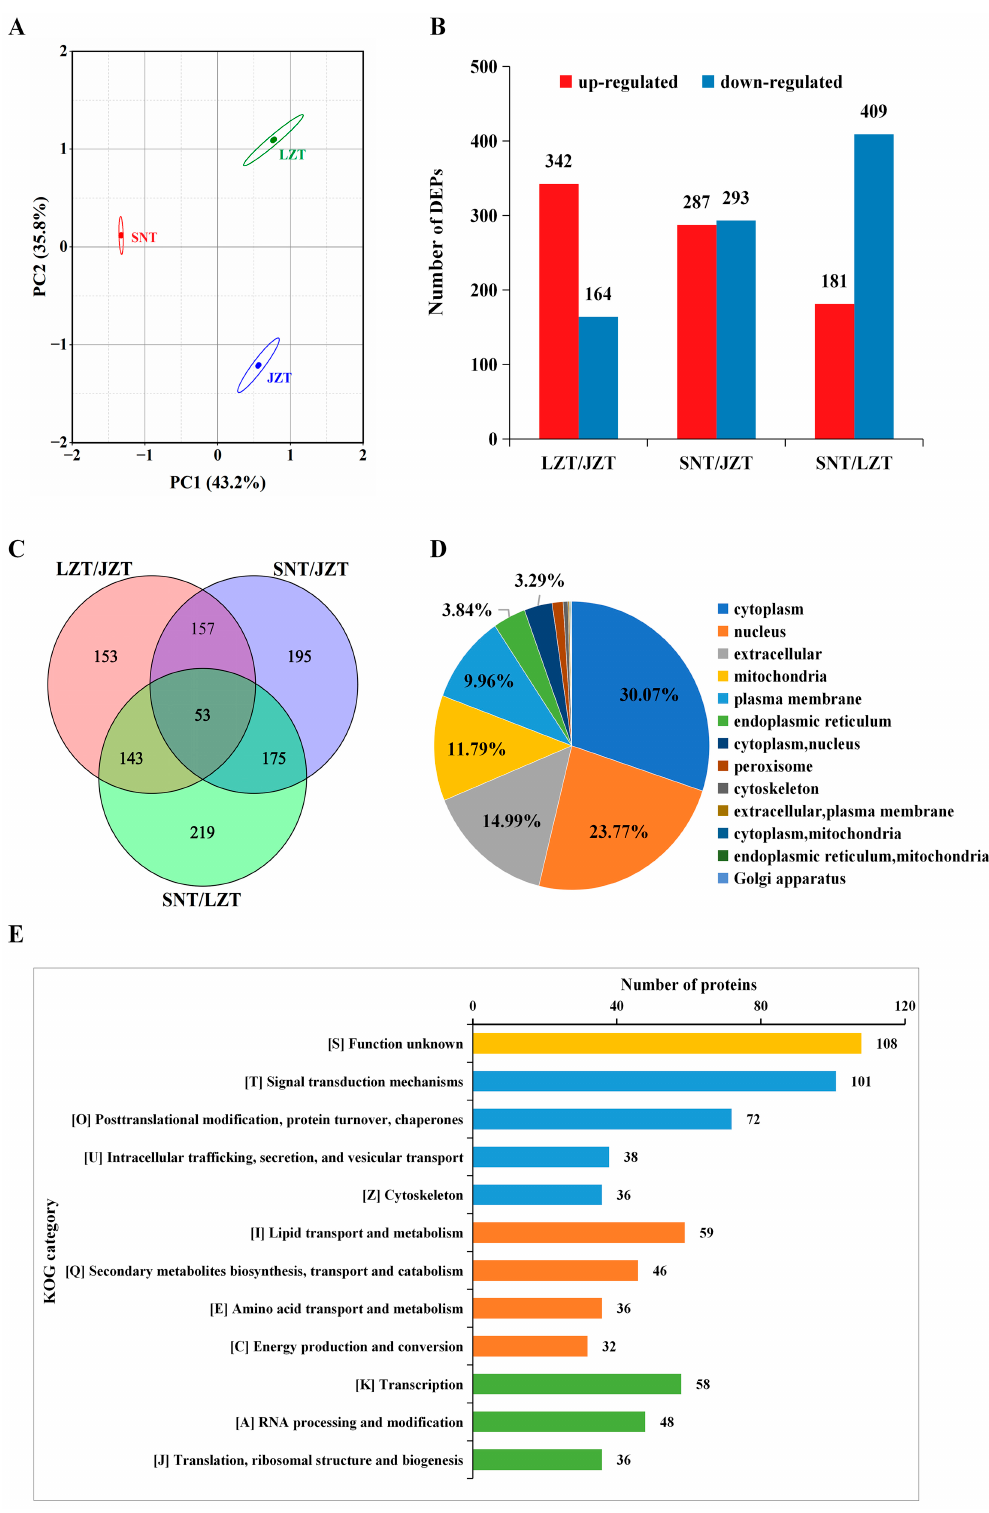
Figure 2. Characteristics and annotation of differentially expressed proteins (DEPs) in Tibetan pig liver. ( A ) Principal component analysis (PCA) analysis of the proteomic profiles of three Tibetan pigs; ( B ) the distribution of DEPs in three groups of Tibetan pig livers; ( C ) Venn diagram of DEPs in three component-pair comparisons; ( D ) subcellular localization annotation of DEPs; ( E ) COG/KOG annotation of DEPs.